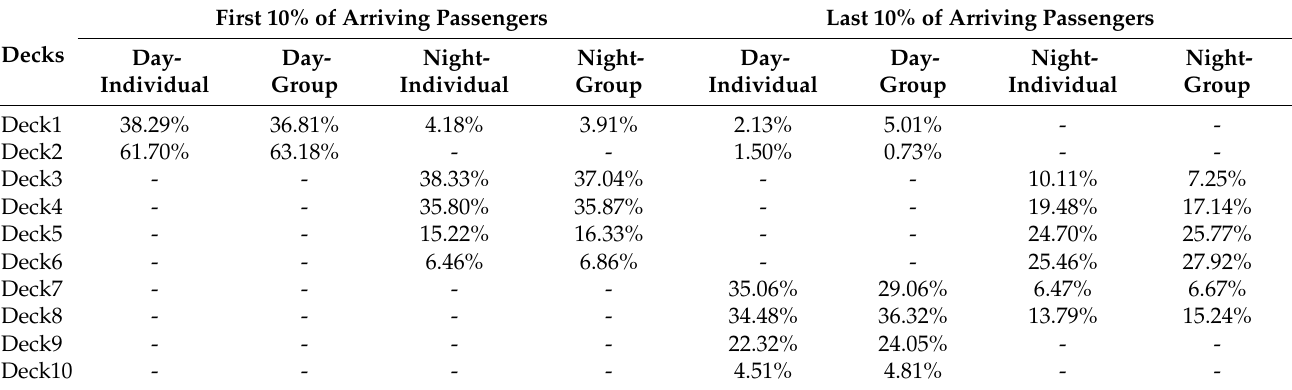
Table 4. Proportions of passengers on different decks.